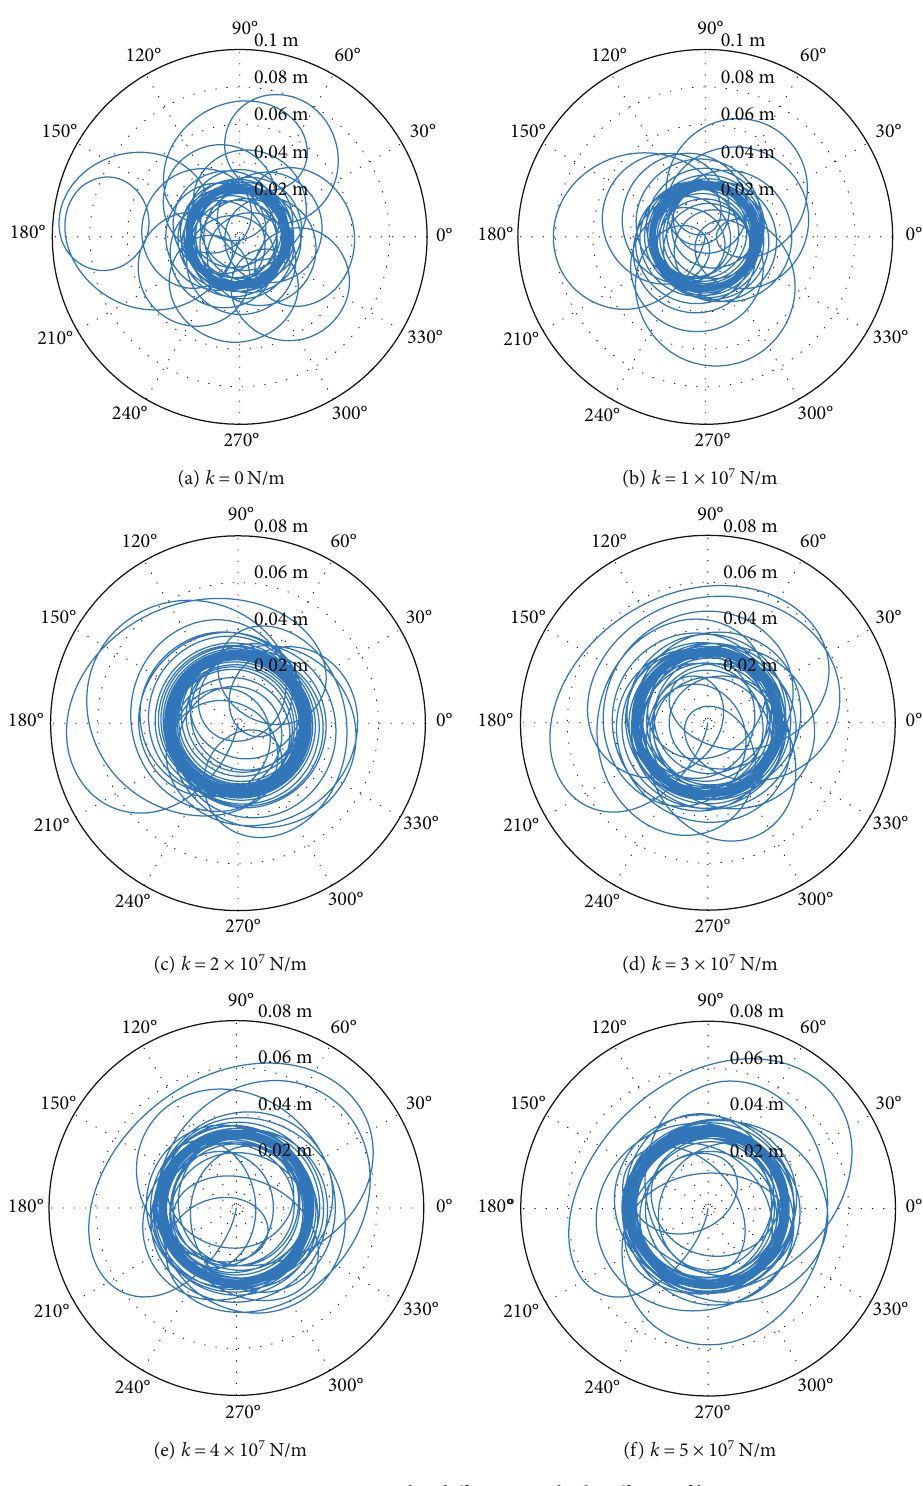
Figure 16: Response trace under di ff erent residual sti ff ness of bearing